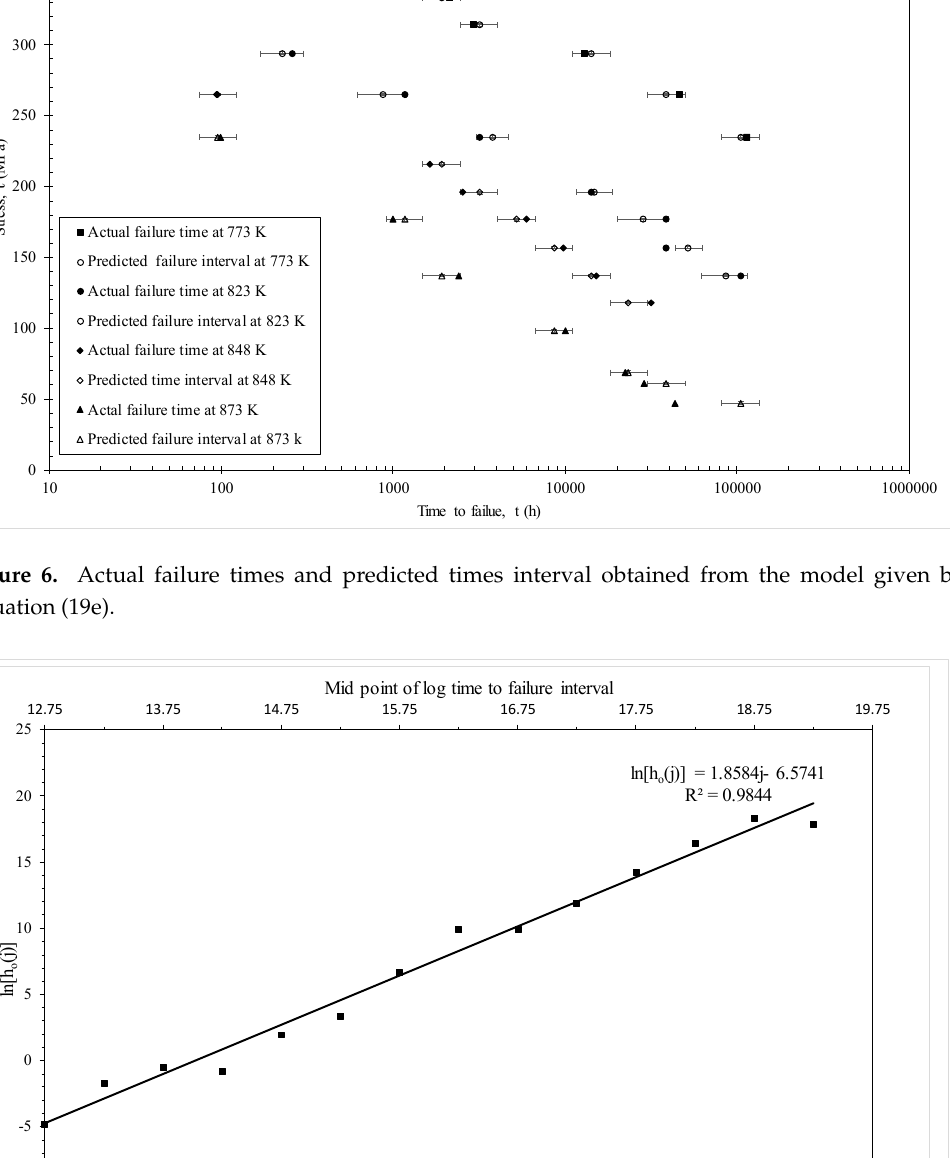
Figure 5. The receiver operating characteristic (ROC) from model given by Equation (13e).